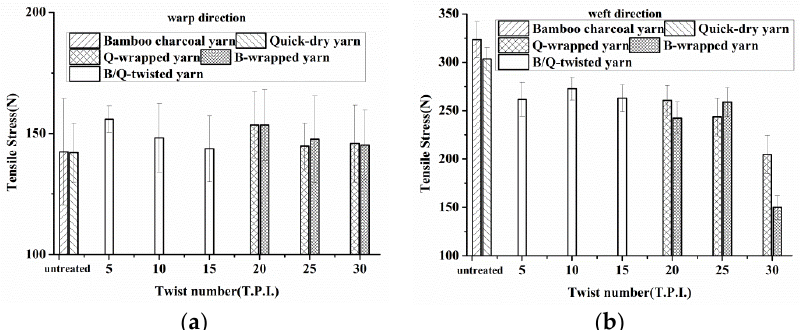
Figure 6. Tensile stress along ( a ) the warp direction and ( b ) weft direction of functional elastic knits in relation to the administration of a wrapping/twisting process, as well as the twist number of the yarns. The error bar indicates the SD.